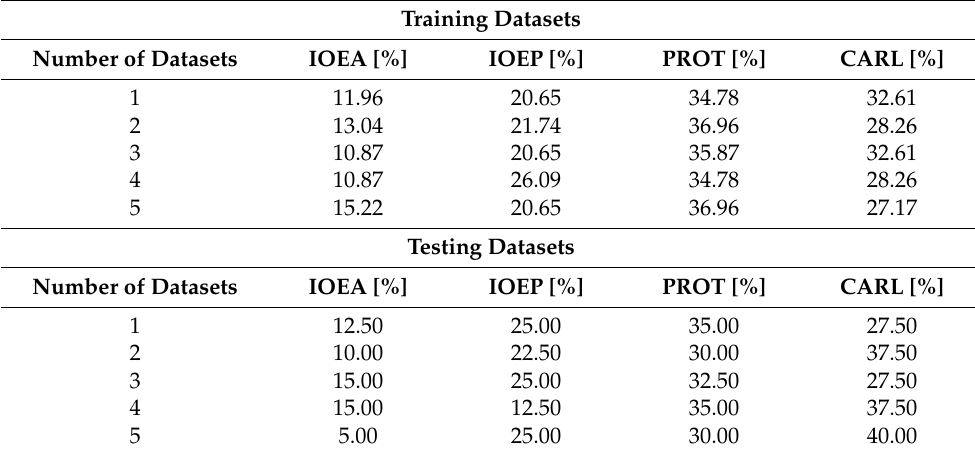
Table 5. Percentage share of each database in the training and testing datasets for the VTI method.